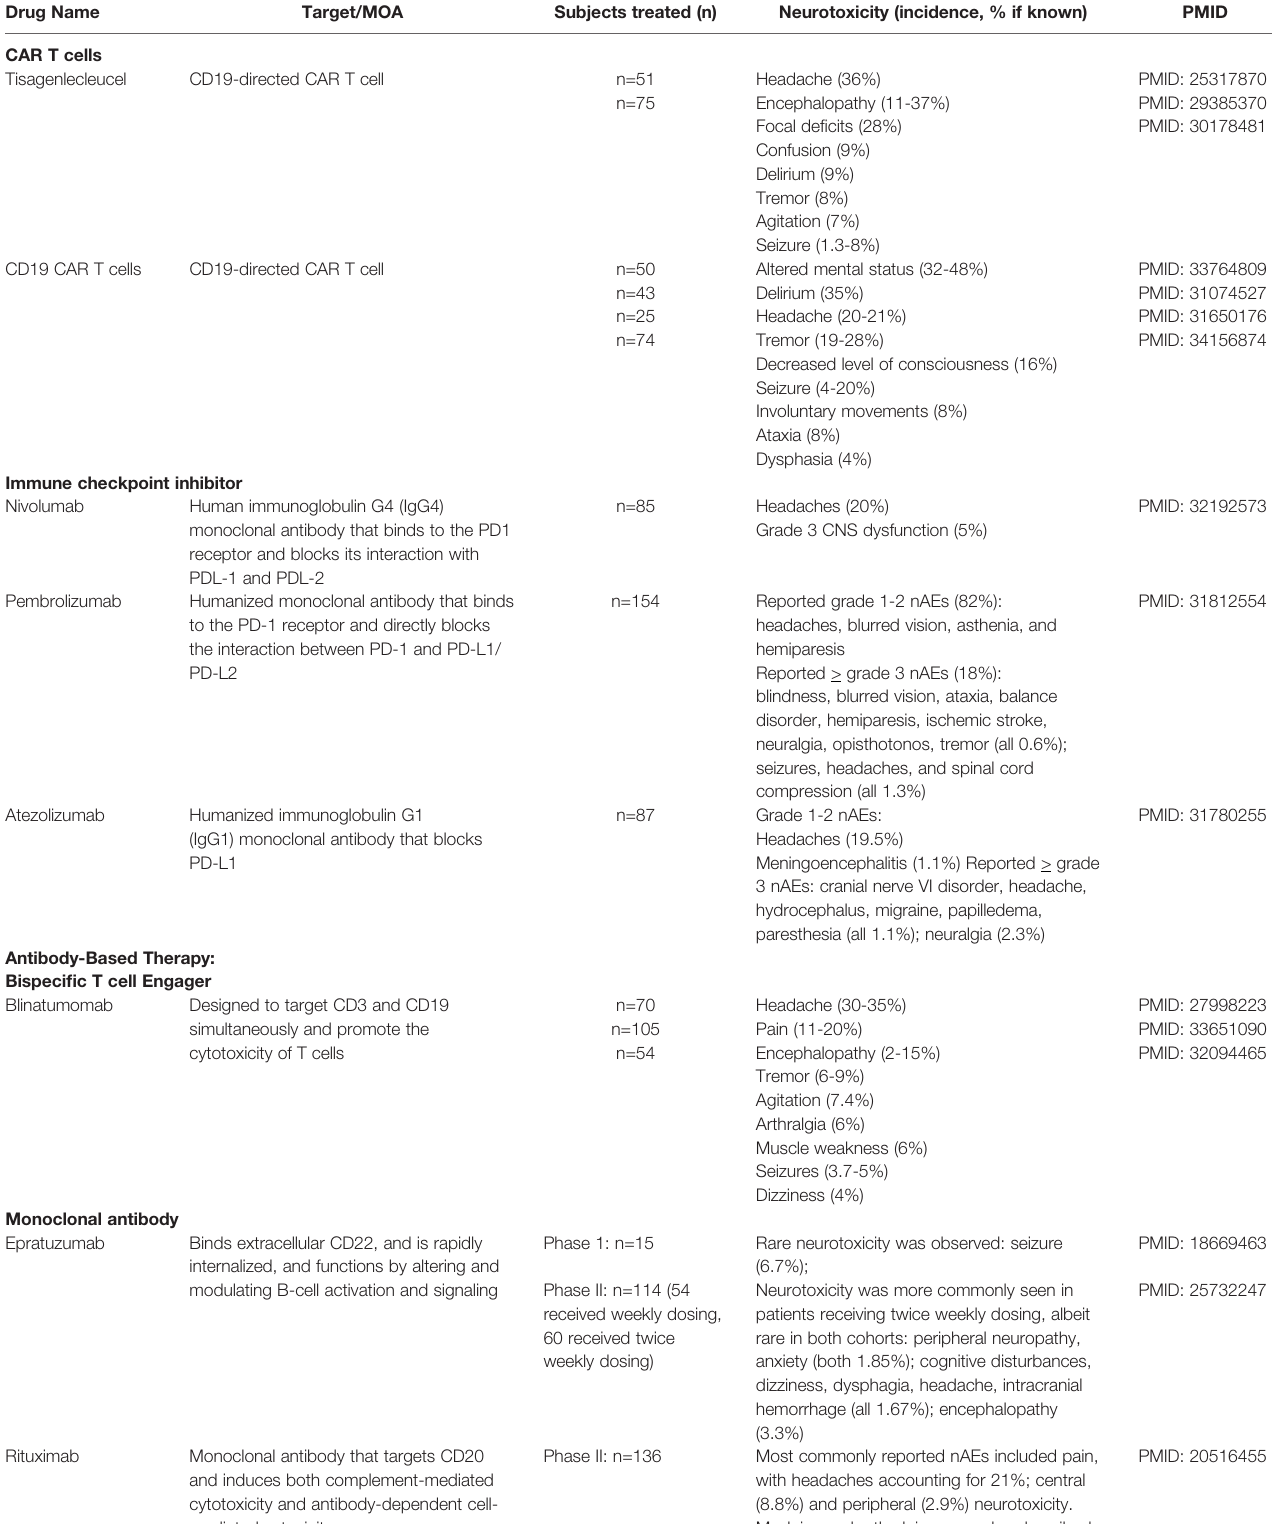
TABLE 3 | Select Pediatric Clinical Trials with Speci fi c Neurotoxicity Descriptions. Drug